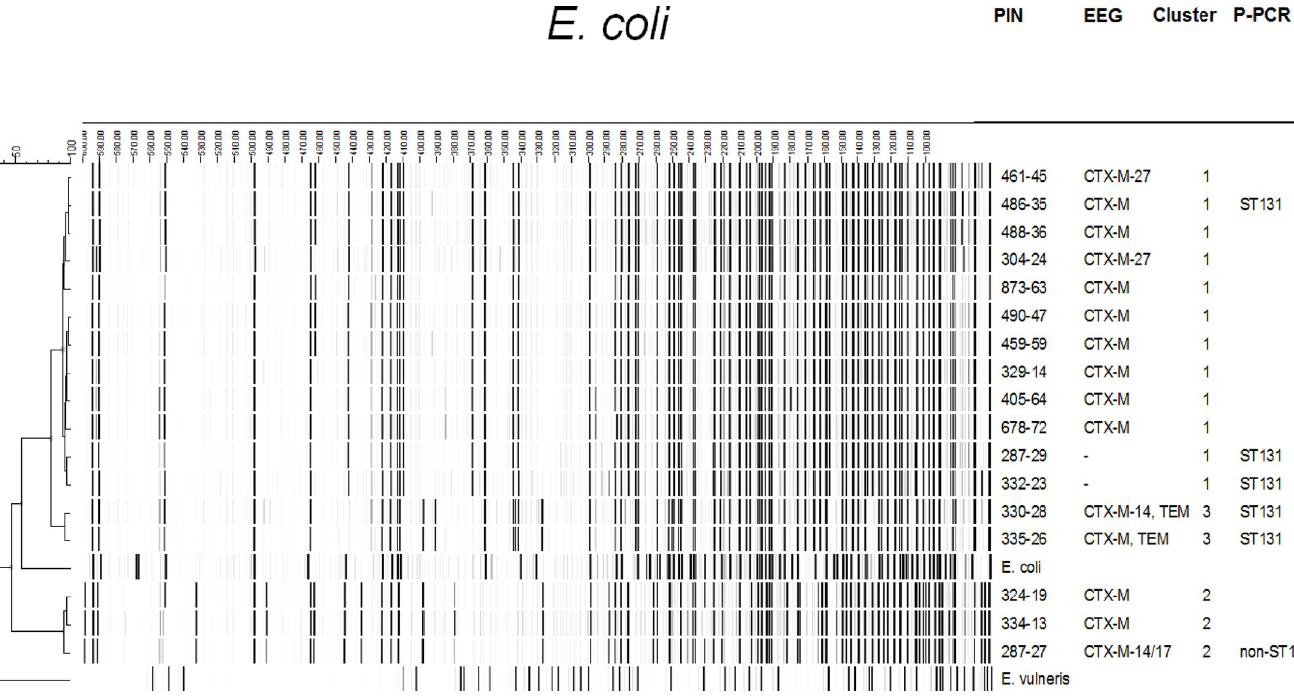
PLOS ONE | https://doi.org/10.1371/journal.pone.0222200 September 12,